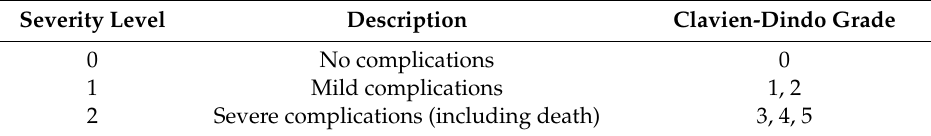
Table 4. Adaption of the Clavien-Dindo